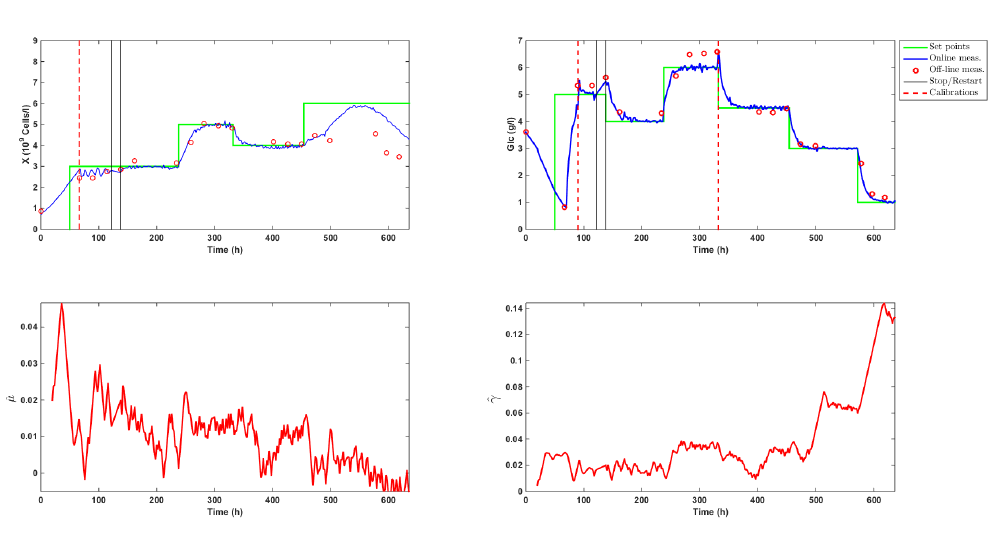
Figure 5. Time evolution of the biomass (X) and glucose (Glc) concentrations and estimation of the